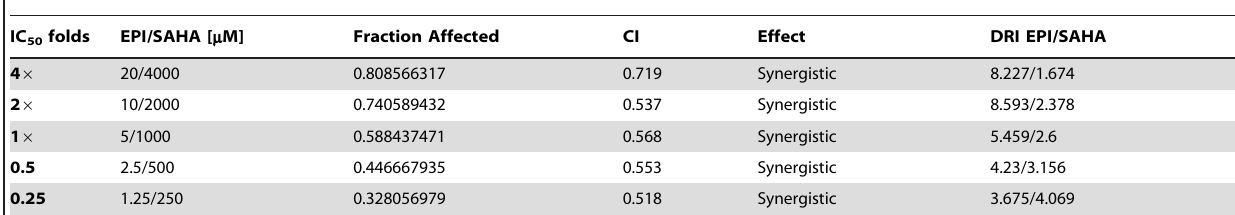
Table 2. Combination of SAHA and epirubicin in MTT